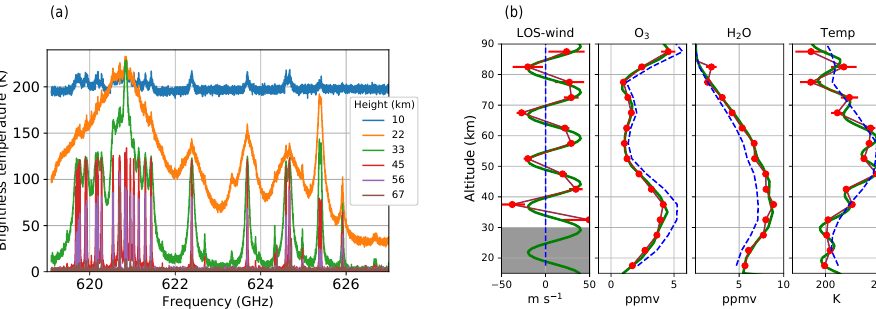
Figure 6. (a) Double sideband spectra with respect to the lower sideband frequency. Only a few spectra of the full vertical scan are shown (see legend). (b) Retrieved profiles with a vertical resolution of 5km for nighttime arctic conditions. The blue-dashed lines are the a priori profiles (first guess), the green lines are the truth and the red line circles are the retrieved values. The horizontal bars indicate the 1 σ errors due to instrument thermal